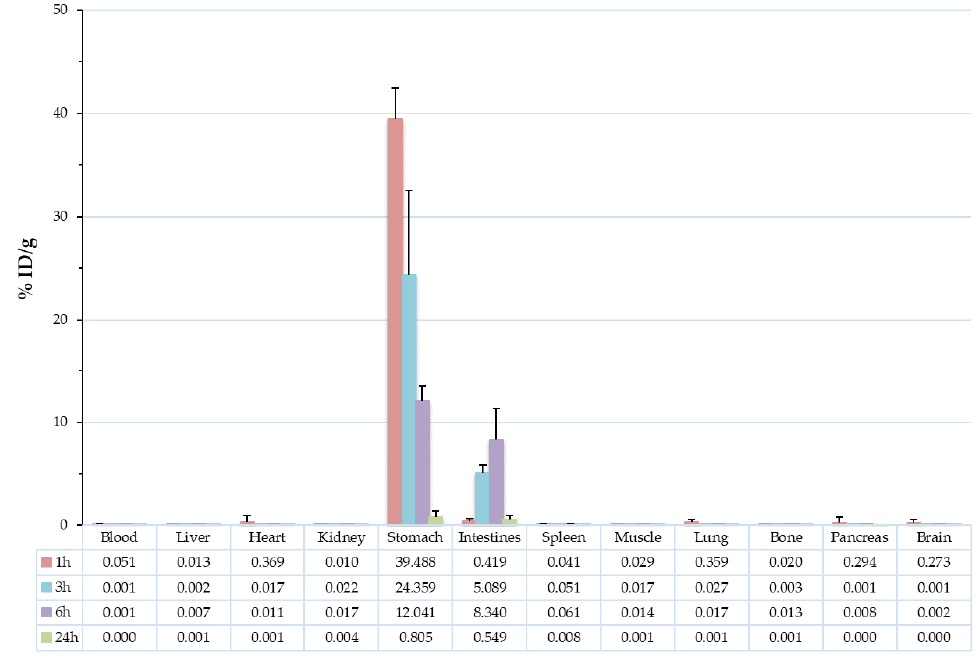
Figure 6. Biodistribution of [ 99m Tc]Tc-CMK-1 in CFW mice at 1, 3, 6 and 24 h post-administration. Table 2. Biodistribution data of [ 99m Tc]Tc-CMK-1 in CFW mice at 1, 3, 6 and 24 h